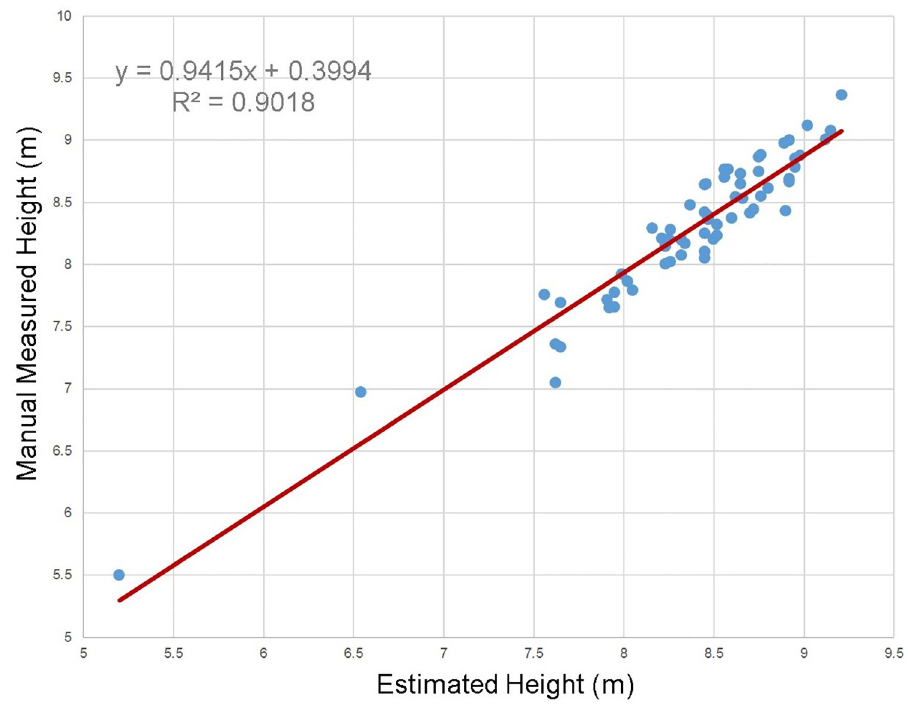
Fig 12. The scatterplot of the tape-measured DBH and the estimated DBH.